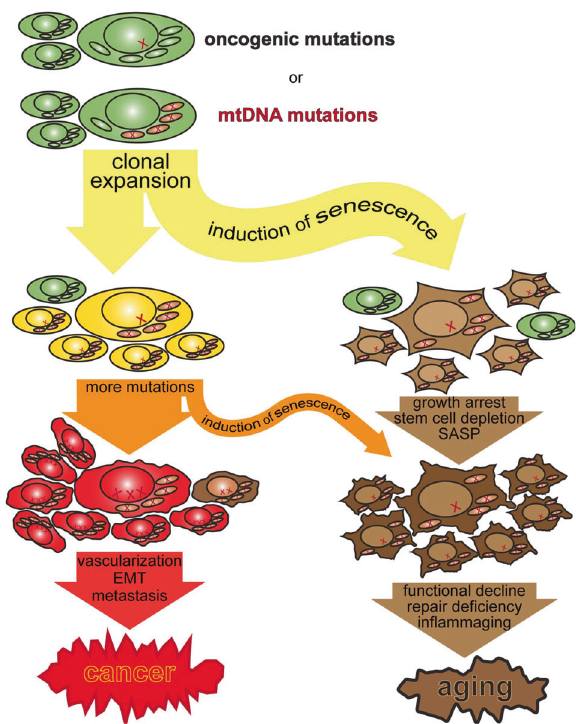
Fig. 1 Cancer and aging as the dual consequences of somatic nDNA and mtDNA mutations. Oncogenic and mtDNA mutations drive clonal expansion, which triggers tumor-suppressive cell senescence but eventually leads to the characteristic loss of repair and regenerative capacity in aging. What we experience as aging is simply, and mostly, the consequence of a tumor-suppressive irreversible growth arrest that has evolved to limit the tumorigenic potential of clonally expanding